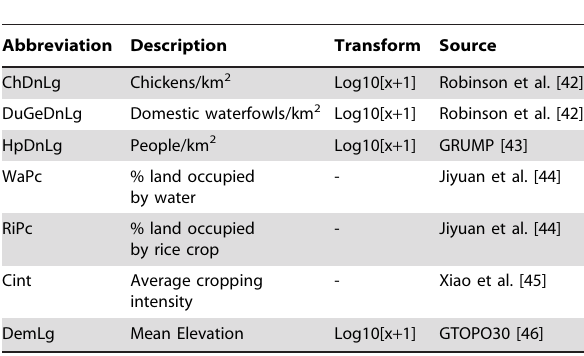
Table 1. Risk factor variables used in the